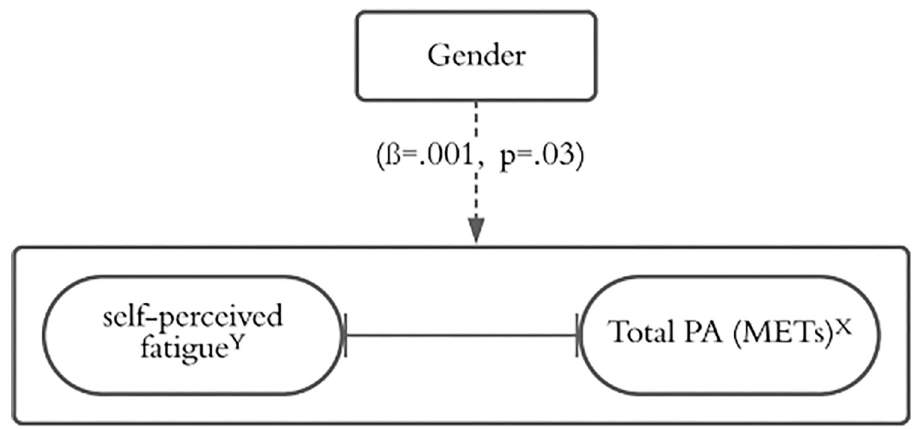
Fig 1. Moderating effect of gender on the relationship between self-perceived fatigue and moderate related PA ( Y denotes the dependent variables; x denotes the independent variables).